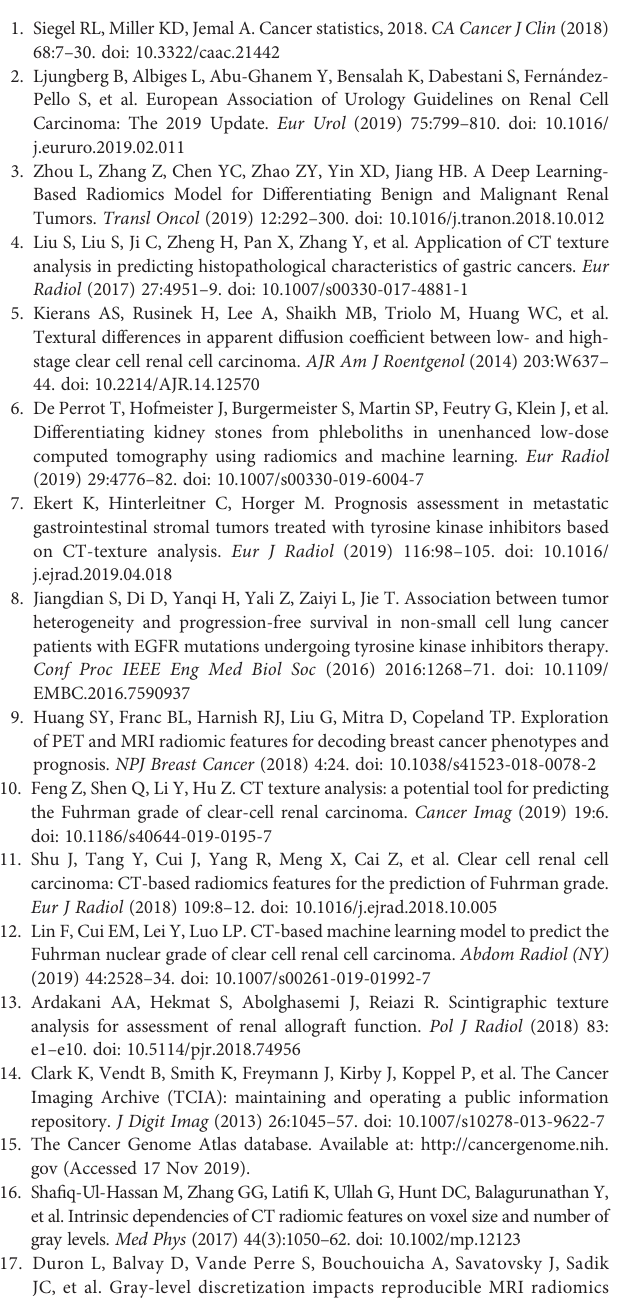
genes with p<0.05 and p<0.005 respectively in predicting both OS and DFS were included. Supplementary Figure 2 | The exact values before and after the Combat harmonization of nephrographic radiomic features that are included in the fi nal predictive model. Supplementary Figure 3 | C-index examination of different models predicting either OS or DFS at different time points. 1000 bootstrapping replications were used. OS, Overall survival; DFS, Disease-free survival; C-index, concordance